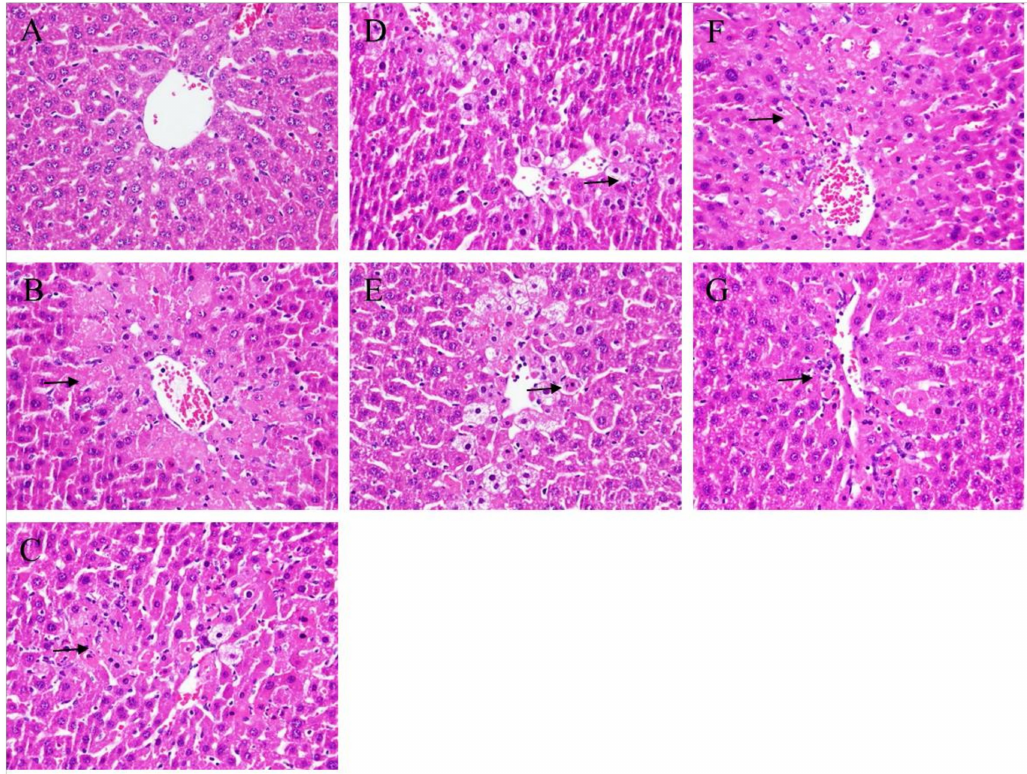
Figure 2. Hepatichistological analyses to the effect of different fractions by black garlic and silymarin on CCl 4 -induced acute liver damage in mice. Liver tissues were stained with H & E (400X). ( A ) control group; ( B ) animals treated with CCl 4 displayed cell necrosis (short arrow); ( C ) animals pre-treated with silymarin and then treated with CCl 4 ; ( D ) animals treated with BA (0.2 g/kg), and then treated with CCl 4. ; ( E ) animals treated with BA (0.5 g/kg), and then treated with CCl 4 ; ( F ) animals treated with WS (0.2 g/kg), and then treated with CCl 4 ; ( G ) animals treated with WS (0.5 g/kg), and then treated with CCl 4 . BA: n -butanol layer extract; WS: water layer